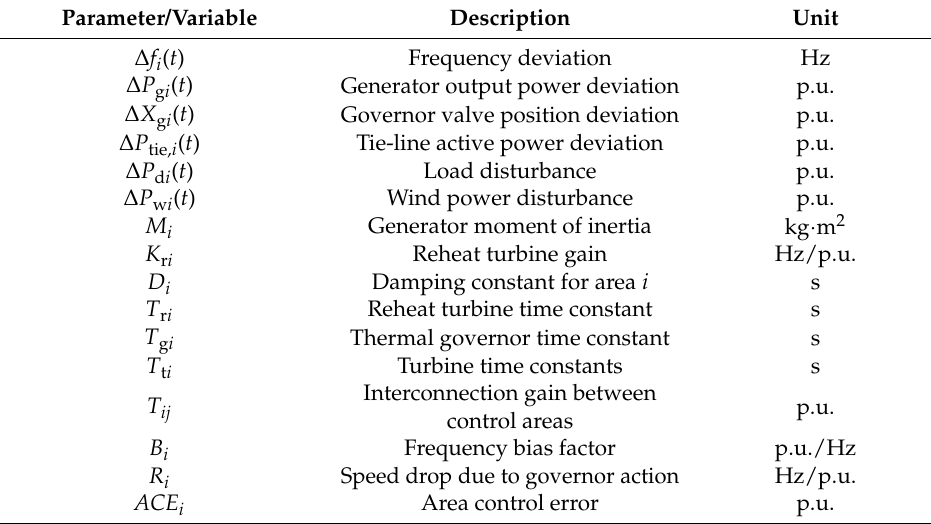
Table 1. Automatic generation control (AGC) system parameters description.